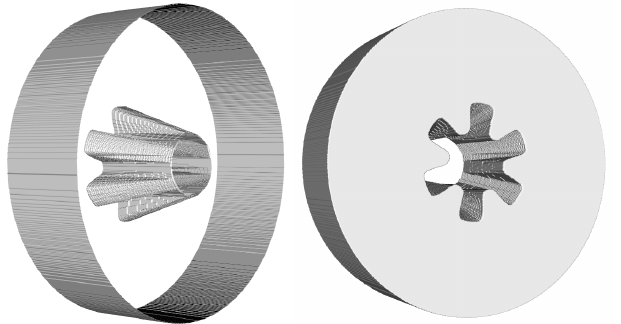
Figure 2. Grain reconstructed based on CT image.